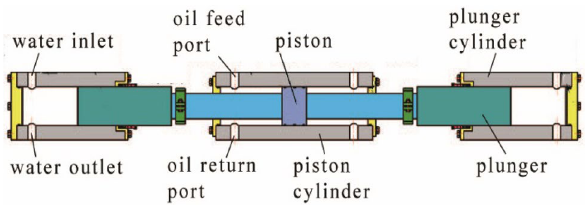
Fig. 5 Functional scheme of the double-acting plunger pump